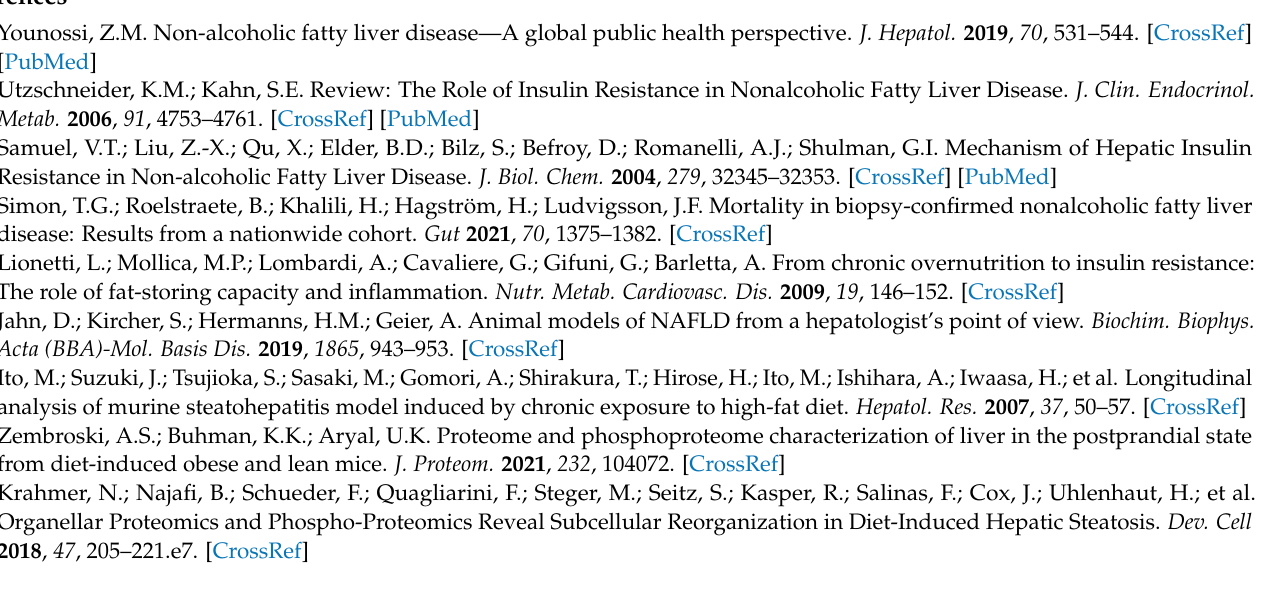
Table S3: List of all lipid features identified. Table S4: Free fatty acids identified by GC–MS and normalized to C17. Table S5: Correlation analysis between total proteins and lipids. Table S6: Correlation analysis between phosphosites and